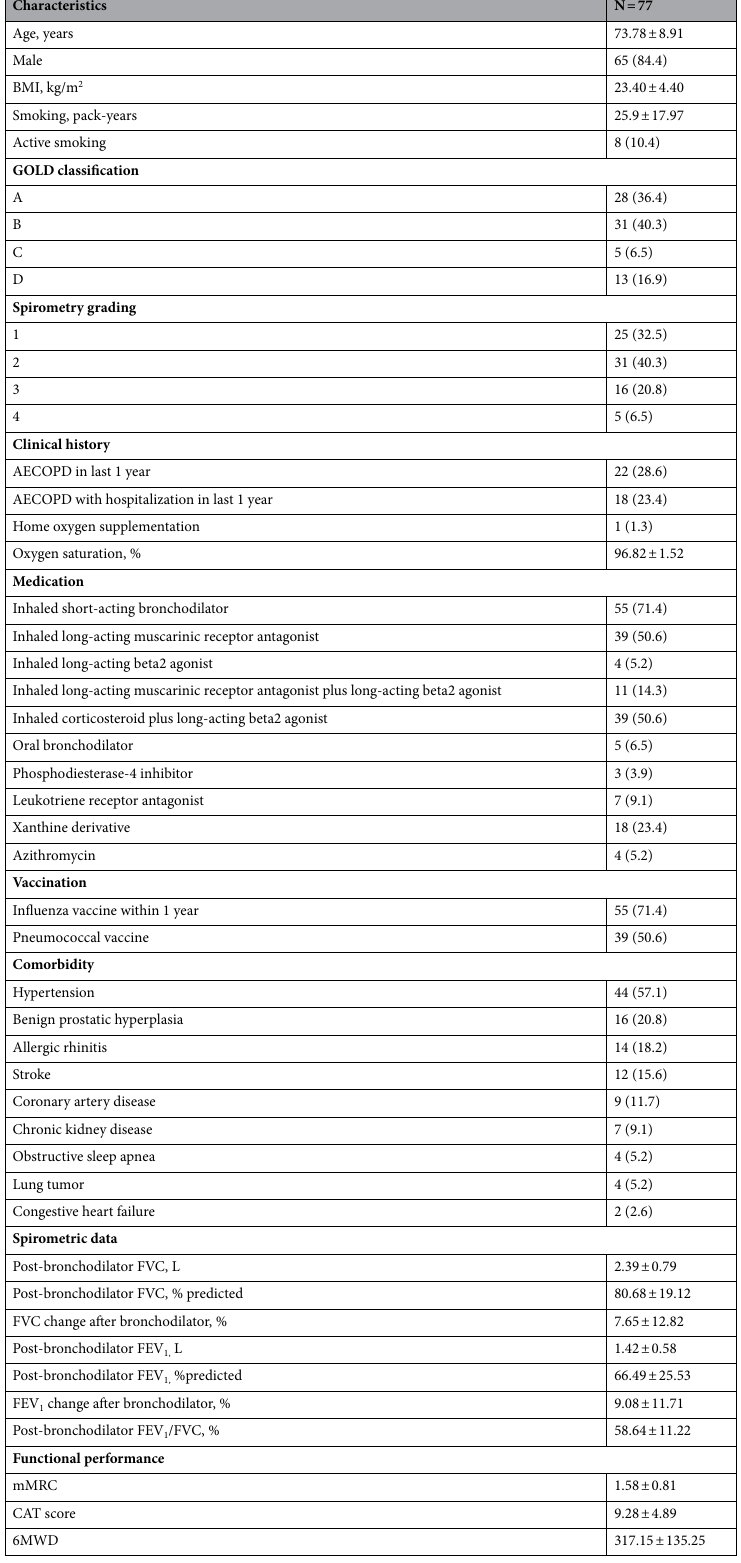
Table 1. Demographic and baseline characteristics of COPD subjects. Data shown as mean ± SD or n(%). BMI body mass index, kg kilogram, m meter, AECOPD acute exacerbation of chronic obstructive